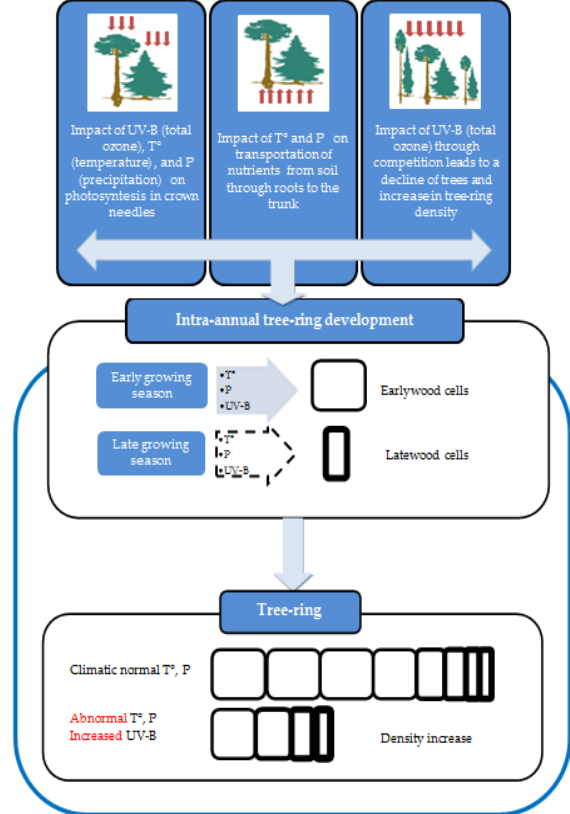
Fig. 12: A block diagram of UV-B (TOC), temperature (T) and precipitation (P) effect on tree-ring structure (cells)